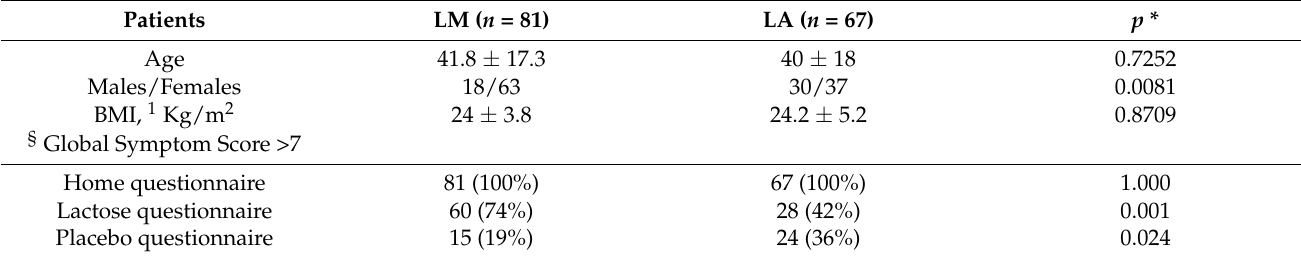
Table 1. Demographic, anthropometric, and clinical findings of the population enrolled in the study subdivided according to lactose hydrogen breath test